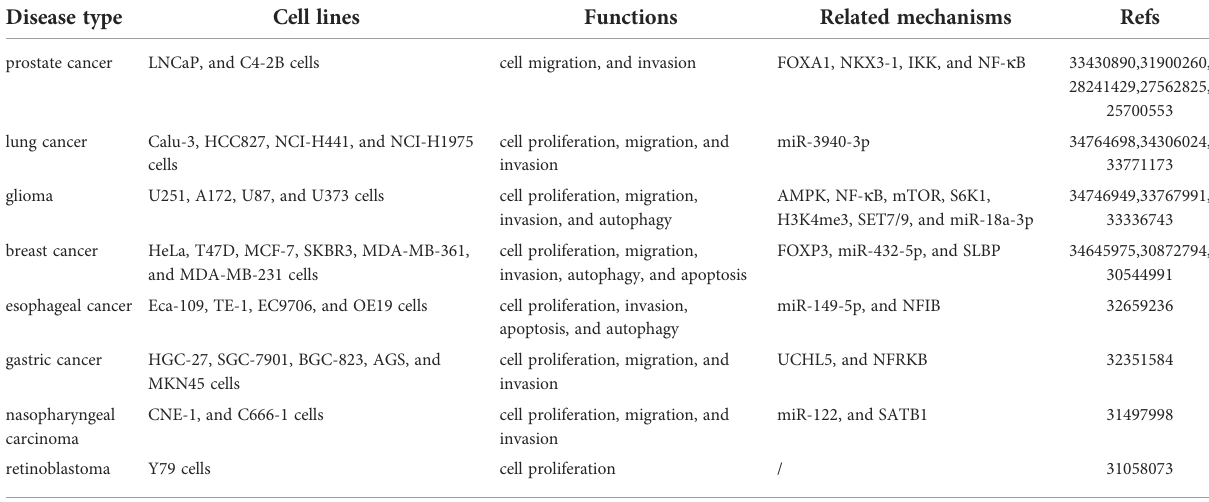
TABLE 2 Functions and mechanisms of lncRNA DRAIC in